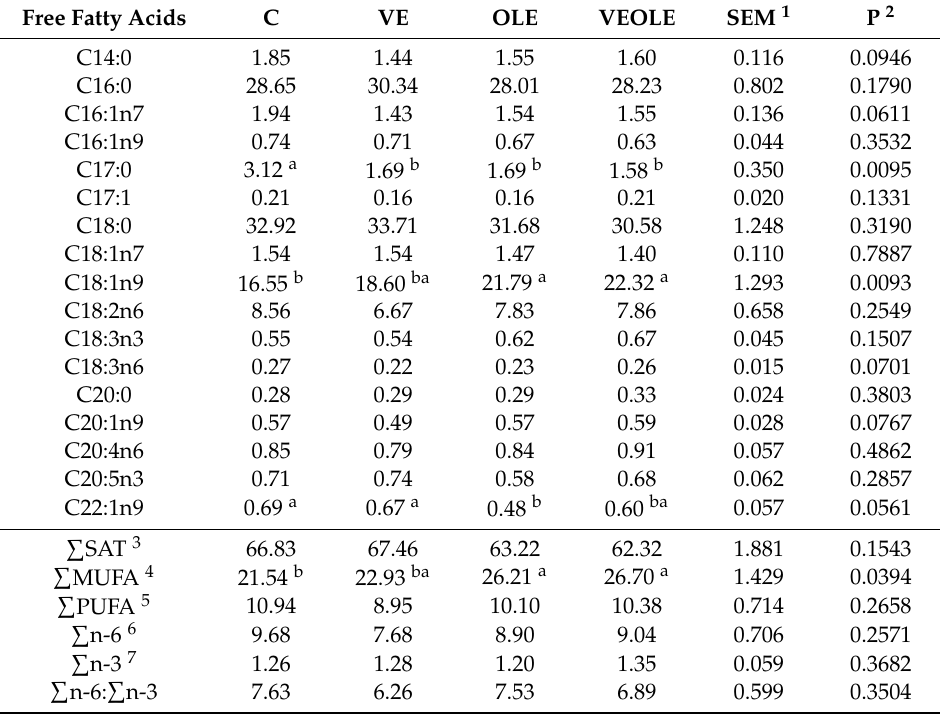
Table 4. E ff ect of dietary oleuropein (OLE), vitamin E and selenium (VE), or their combination (VEOLE) on the free fatty acid fraction (g / 100 g total fatty acids) of plasma samples from pigs fed the experimental diets.